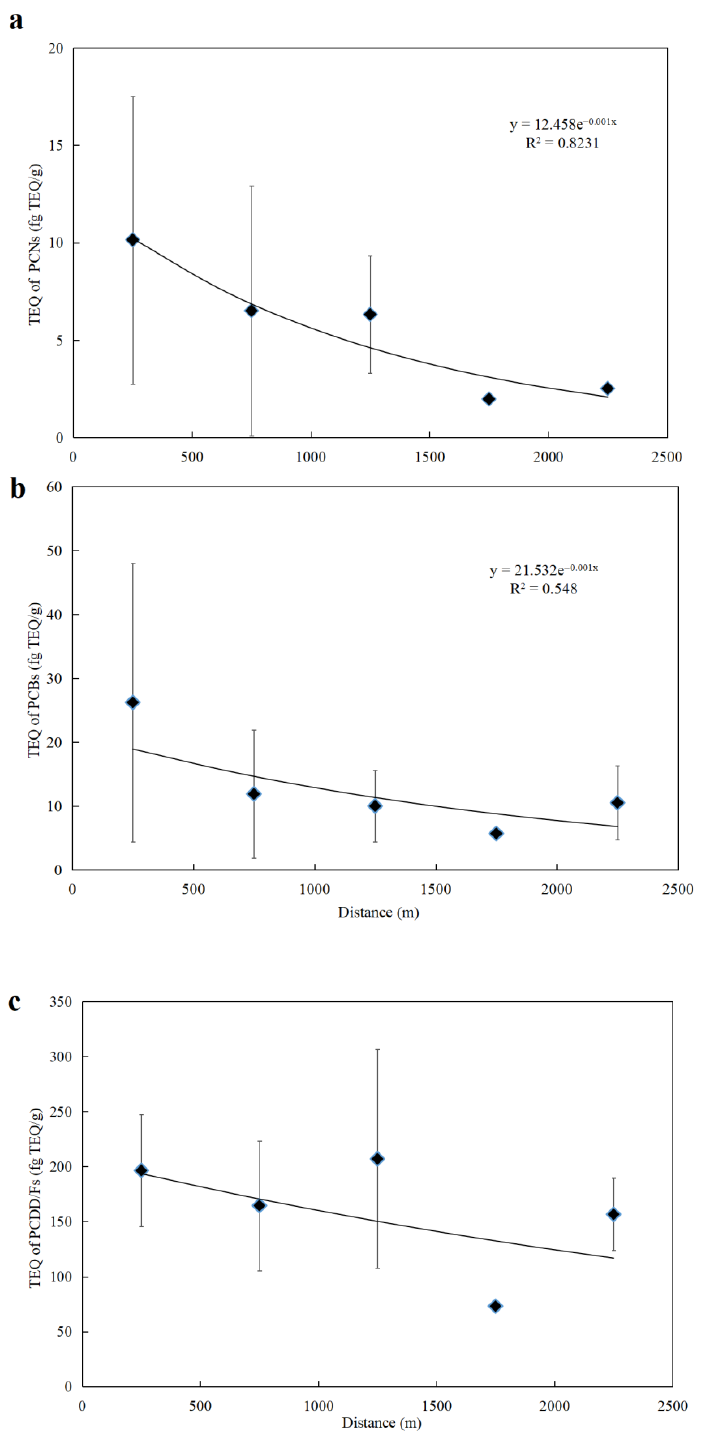
Figure 2. Relationship between distance from the cement kiln co-processing municipal wastes stack and TEQ of PCNs ( a ), PCBs ( b ), and PCDD/Fs ( c ).